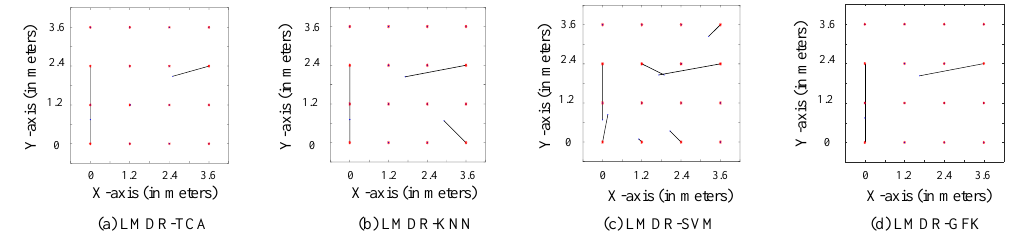
Figure 10. Localization performance of the different methods ( T 1 - T 2